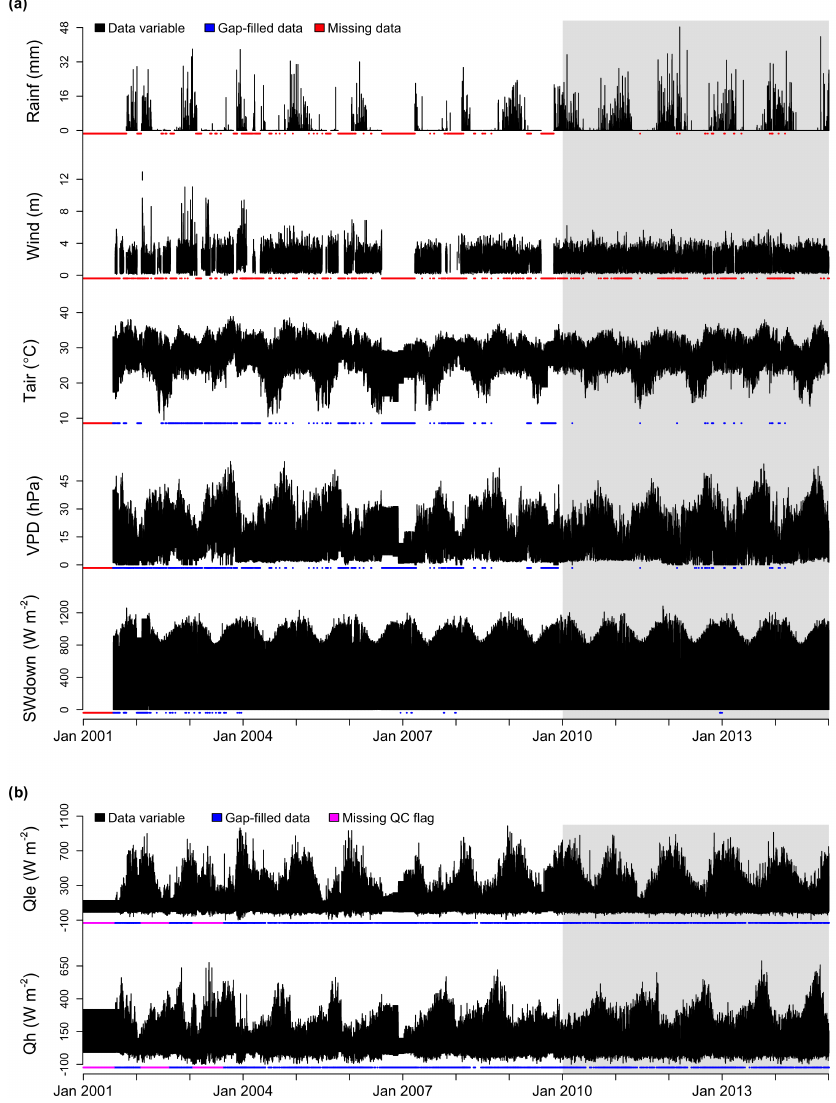
Figure 3. Half-hourly time series of (a) essential meteorological variables and (b) select evaluation variables in Howard Springs. Meteo- rological variables include precipitation (Rainf), wind speed (Wind), air temperature (Tair), vapour pressure deficit (VPD) and incoming short-wave radiation (SWdown). Latent heat (Qle) and sensible (Qh) are shown as examples of evaluation variables. Gap-filled periods are indicated in blue and missing periods in data variables in red. For evaluation variables, periods with missing quality control (QC) flags are shown in